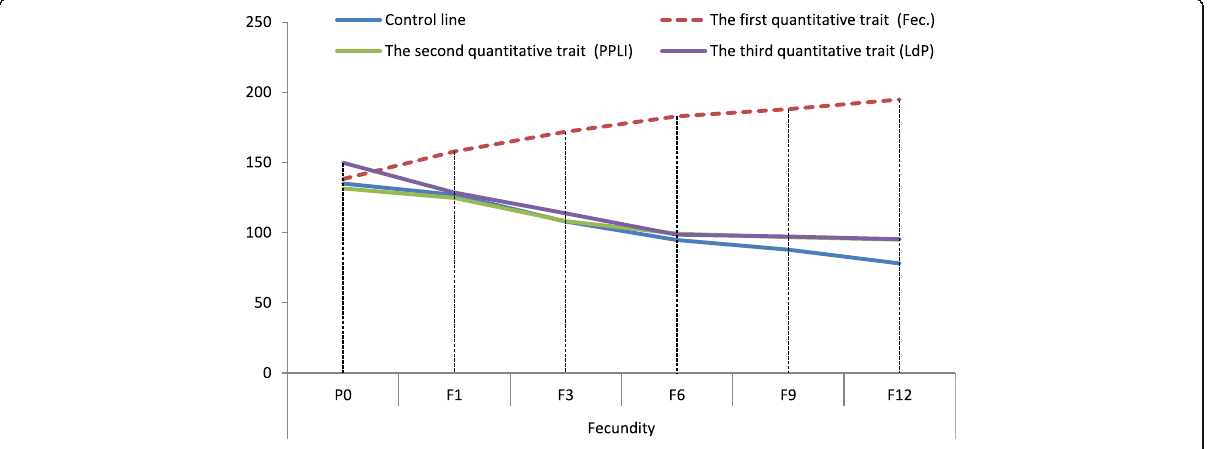
Fig. 1 Changes in the fecundity according to the change of genetic improved lines